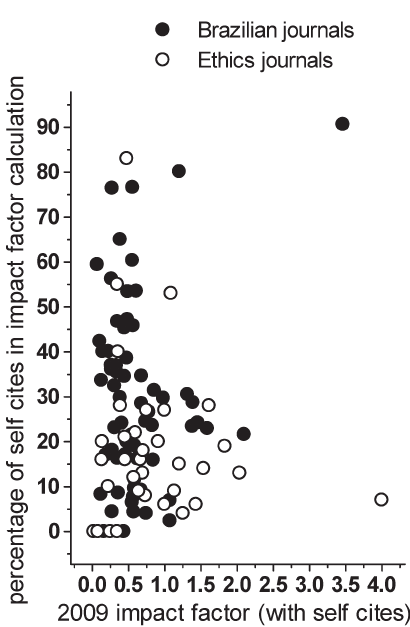
Figure 2 - Impact factors and percentages of self-cites during the years used for impact factor calculation. Brazilian journals are compared with Ethics